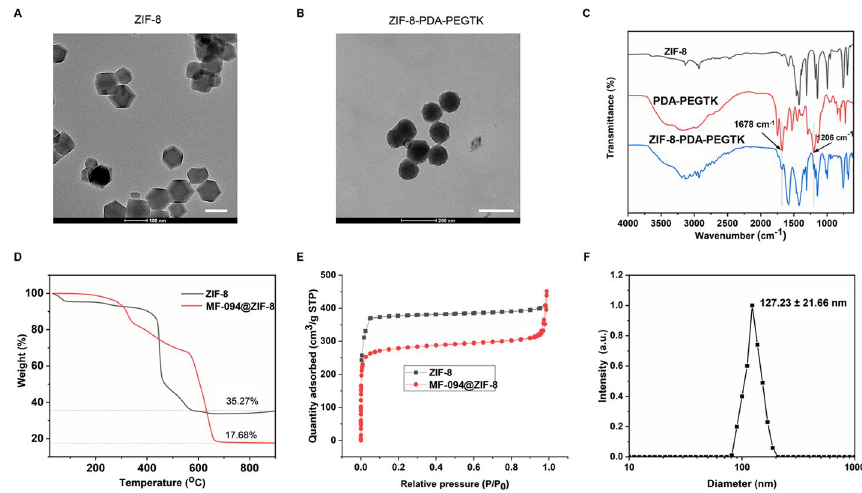
Fig. 5 NP characterization. TEM images of ( A scale bars: 100 nm) ZIF-8 and ( B scale bars: 200 nm) ZIF-8-PDA-PEGTK. C FT-IR images of ZIF-8, TKPDA, and ZIF-8-PDA-PEGTK. D TGA isotherms of ZIF-8 and MF-094@ZIF-8. E N 2 adsorption–desorption isotherms of ZIF-8 and MF-094@ZIF-8. F Size distribution of